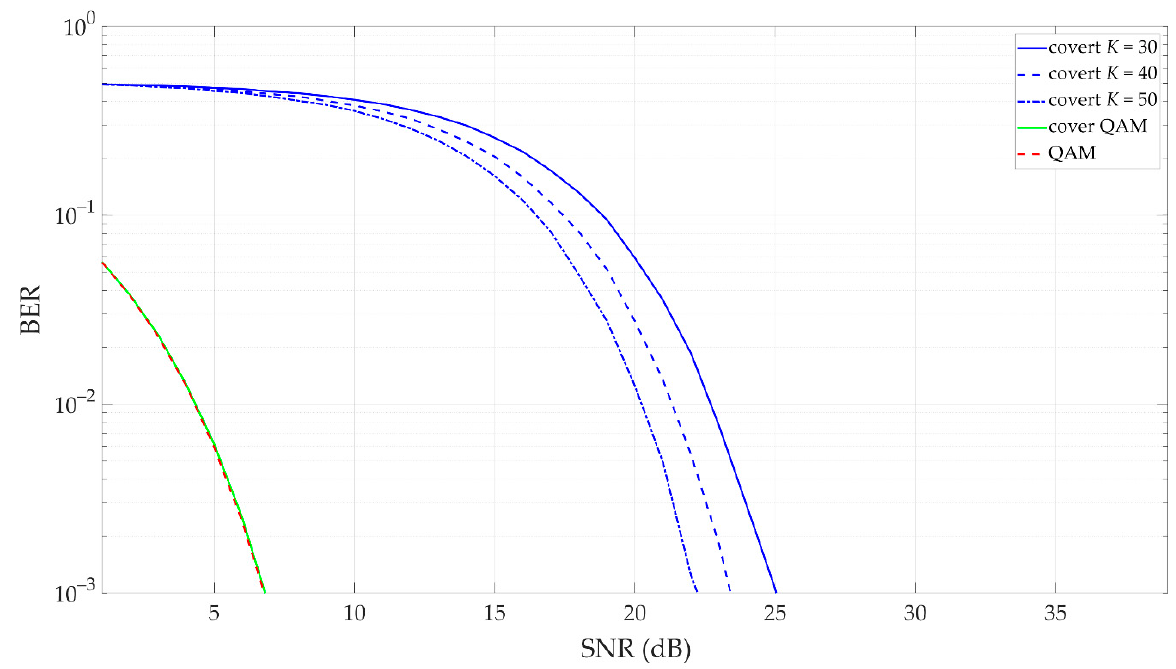
Figure 13. BER versus SNR for different K , random A m , and error vector magnitude (EVM) = 3%.